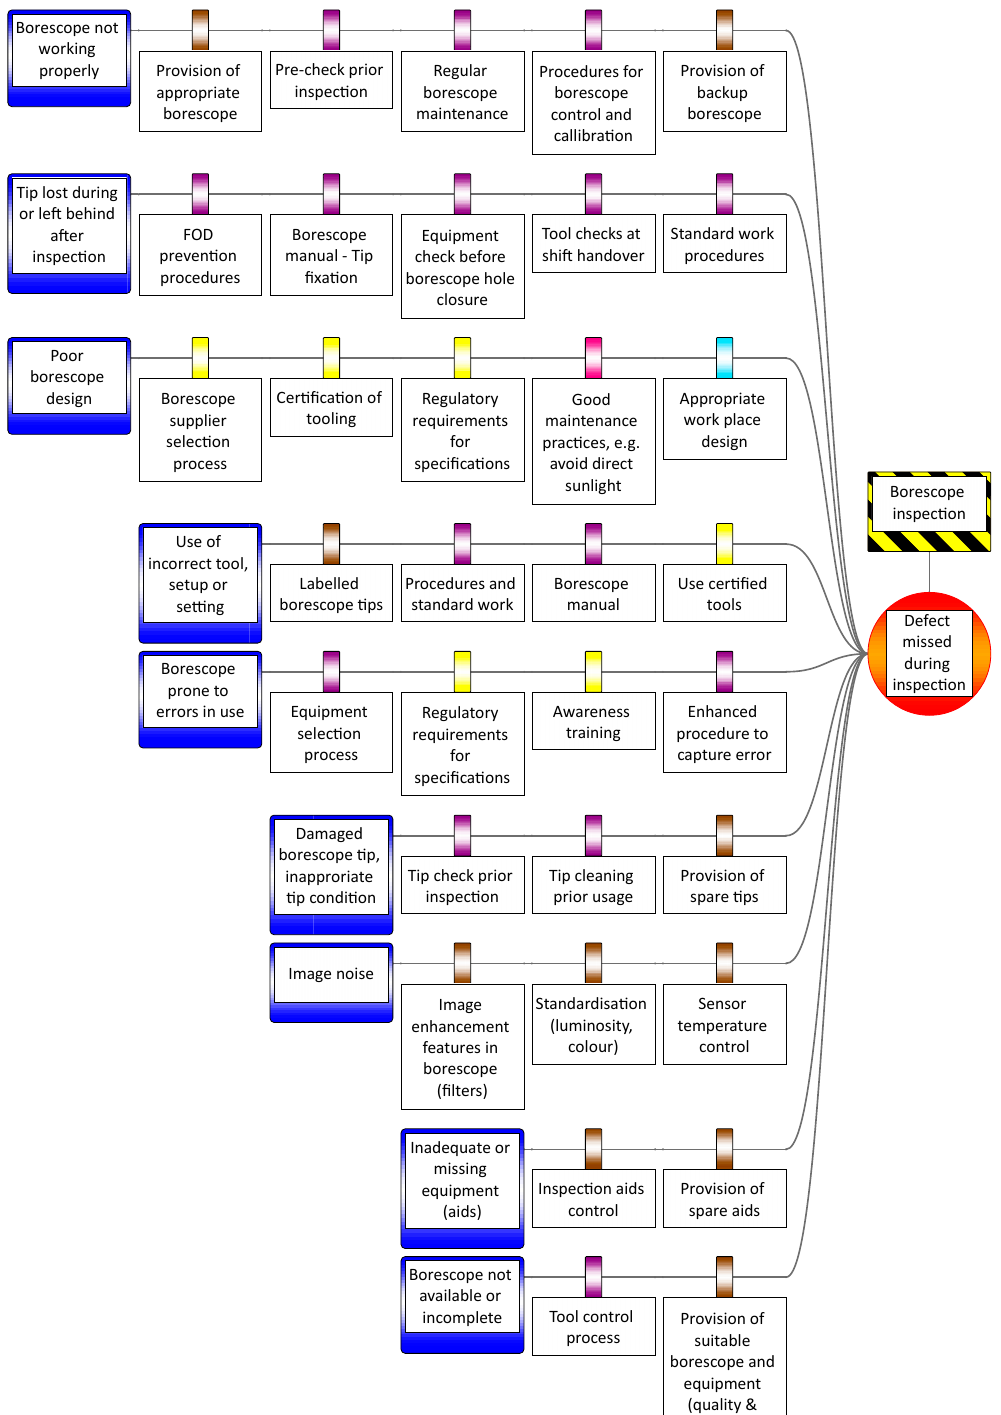
Figure 18. Machine-related threat paths with barriers.